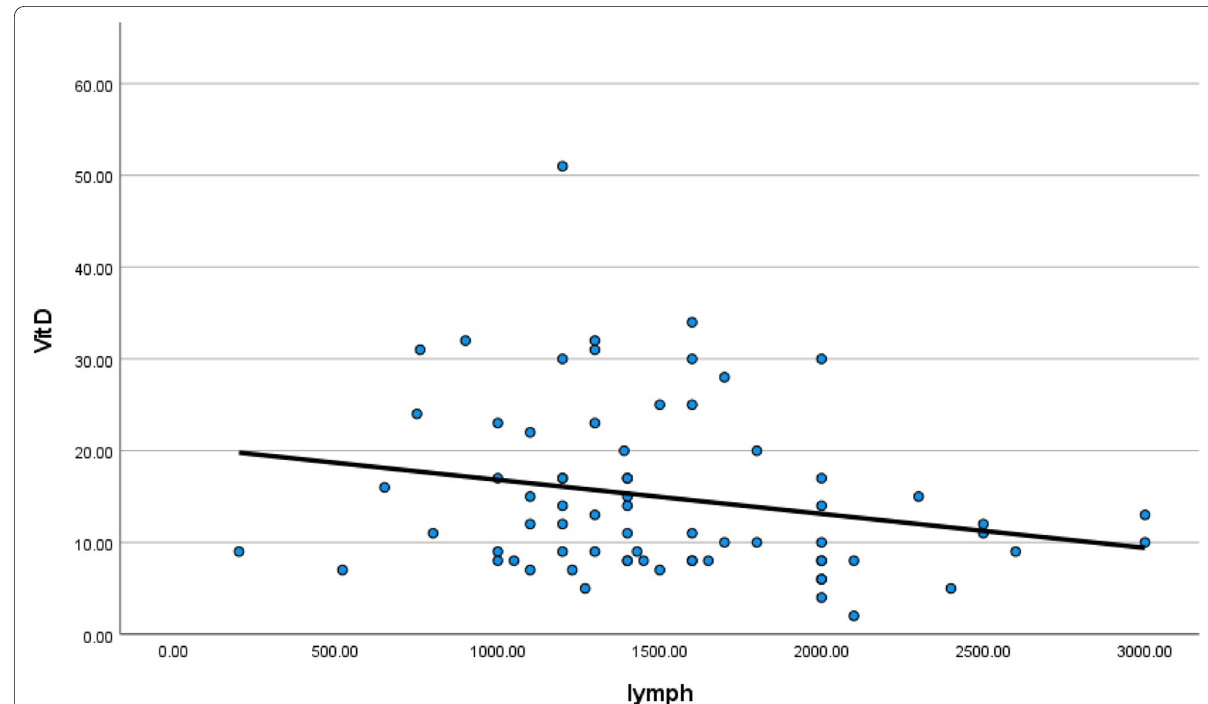
Fig. 22 Correlation between serum vitamin D and lymphocytic count in COVID 19 patients (symptomatic and non-symptomatic)